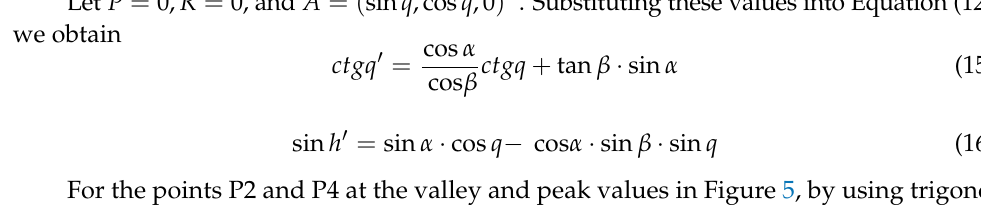
Figure 5. The e ff ect of hull roll and pitch on the elevation error h